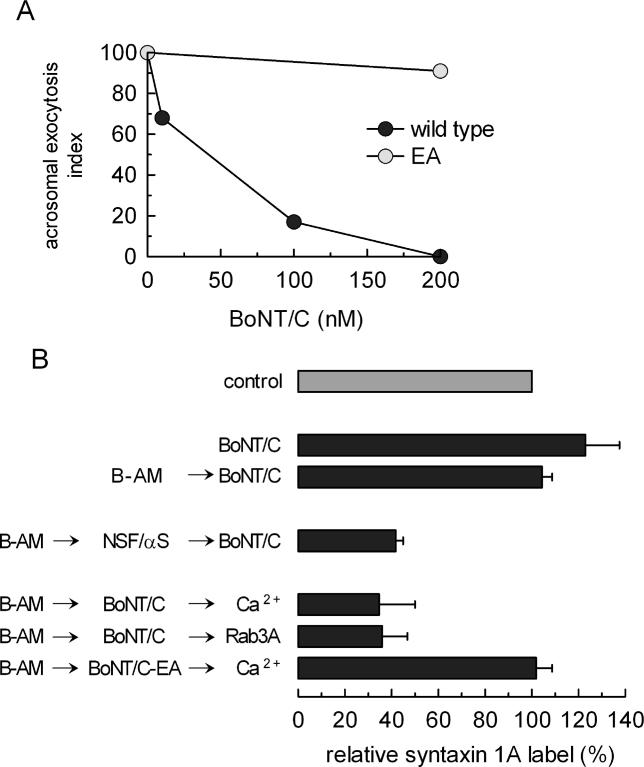
Syntaxin1A Is Assembled in Toxin-Resistant Complexes That Are Disassembled by NSF/α-SNAP or by Sperm Activation(A) Permeabilized spermatozoa were incubated for 15 min at 37 °C with increasing concentrations of BoNT/C (black circles, wild type; grey circles, EA, a protease-inactive mutant) and then stimulated with 10 μM Ca2+ for 15 min at 37 °C. Afterwards, sperm were fixed and AE measured as described in Materials and Methods.(B) To assess the assembly state of syntaxin1A, sperm were incubated with 100 nM BoNT/C (15 min at 37 °C), and the cells were then fixed and immunostained with an anti-syntaxin1A antibody recognizing an epitope that is cleaved by the toxin. To prevent AE, which would release syntaxin into the medium by vesiculation of the acrosome, intra-acrosomal Ca2+ was chelated with 10 μM BAPTA-AM (15 min at 37 °C, B-AM). The toxin treatment in resting sperm (BoNT/C) or B-AM-loaded sperm (B-AM→BoNT/C) had no effect on the syntaxin labeling compared to untreated sperm (control). However, when 310 nM NSF and 500 nM α-SNAP were added to the system to promote the disassembly of SNARE complexes, the toxin significantly decreased the syntaxin labeling (B-AM→NSF/αS→BoNT/C). The BoNT/C treatment also affected syntaxin labeling when sperm were stimulated for 15 min at 37 °C with 10 μM free Ca2+ (B-AM→ BoNT/C→Ca2+) or 300 nM Rab3A (B-AM→BoNT/C→Rab3A). The protease-inactive mutant did not affect labeling under these conditions (B-AM→BoNT/C-EA→Ca2+). Fluorescence was normalized as described in Materials and Methods. The data represent the mean ± SEM. Statistical analysis is provided in Table S5.